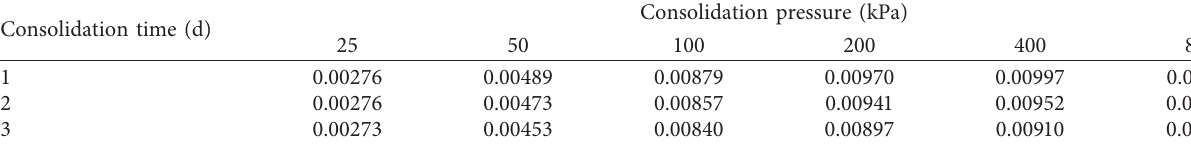
Table 3: The list of secondary consolidation coefficients for different consolidation time periods and different consolidation pressures. Consolidation time (d)